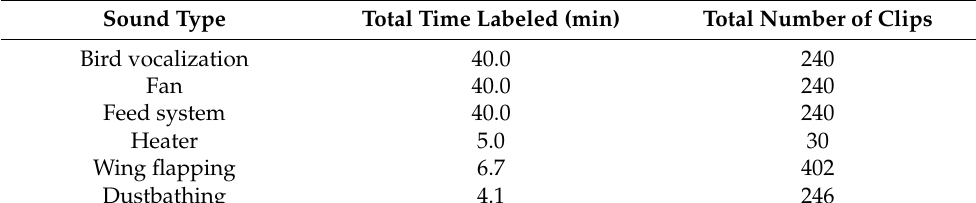
Table 1. Number of events and equivalent time labeled for each type of sound over eight weeks.